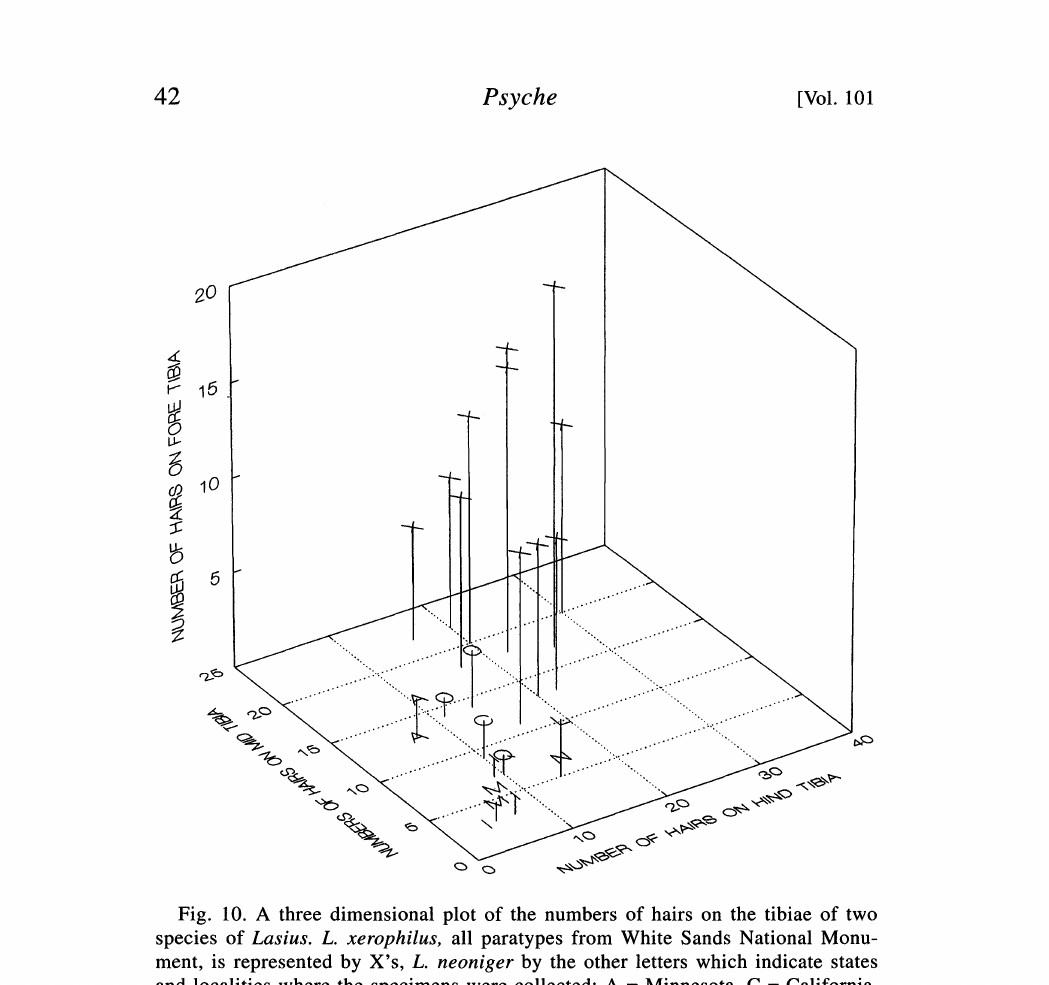
Fig. 10. A three dimensional plot of the numbers of hairs on the tibiae of two species of Lasius. L. xerophilus, all paratypes from White Sands National Monu- ment, is represented by X’s, L. neoniger by the other letters which indicate states and localities where the specimens were collected: